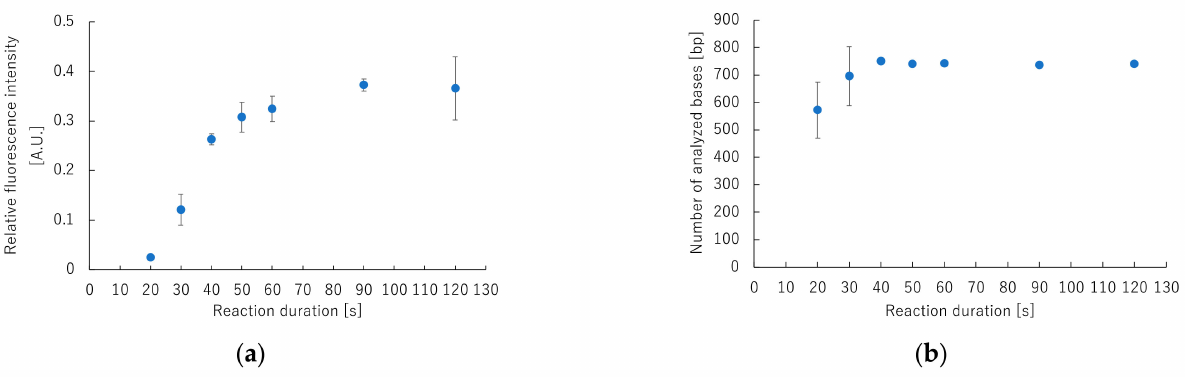
Figure 5. Correlation between fluorescence intensity and number of bases that can be analyzed for each reaction duration of cycle sequencing using capillary DNA sequencer. ( a ) Correlation between relative fluorescence intensity and reaction duration. ( b ) Correlation between the number of analyzed bases and reaction